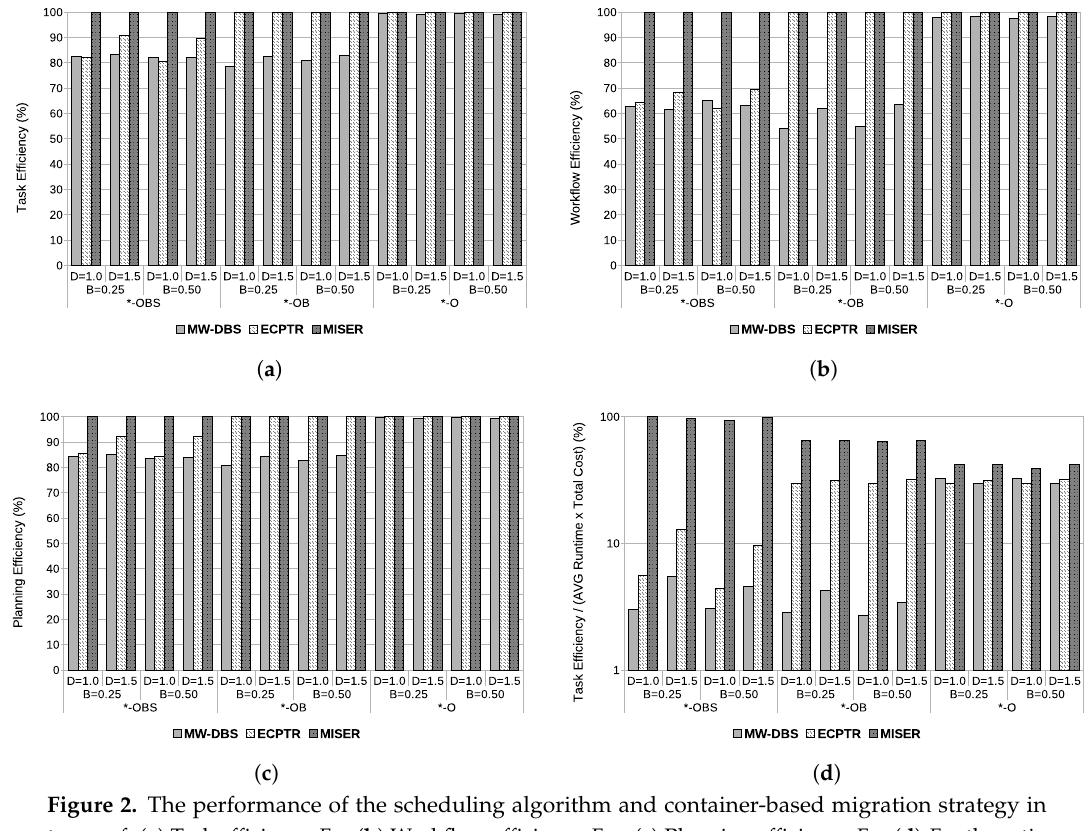
Figure 2. The performance of the scheduling algorithm and container-based migration strategy in terms of: ( a ) Task efficiency E T . ( b ) Workflow efficiency E W . ( c ) Planning efficiency E P . ( d ) E C , the